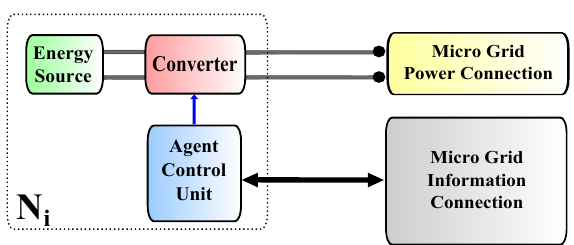
and its subsystems: the energy i